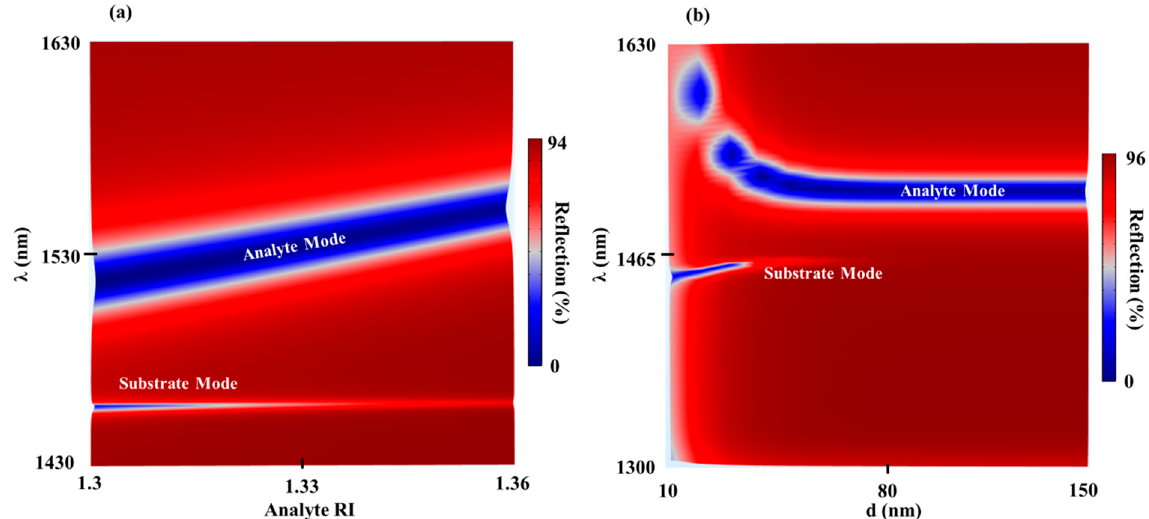
Figure 3. Schematic diagram of the self-referenced sensor based on TDGTMF geometry.